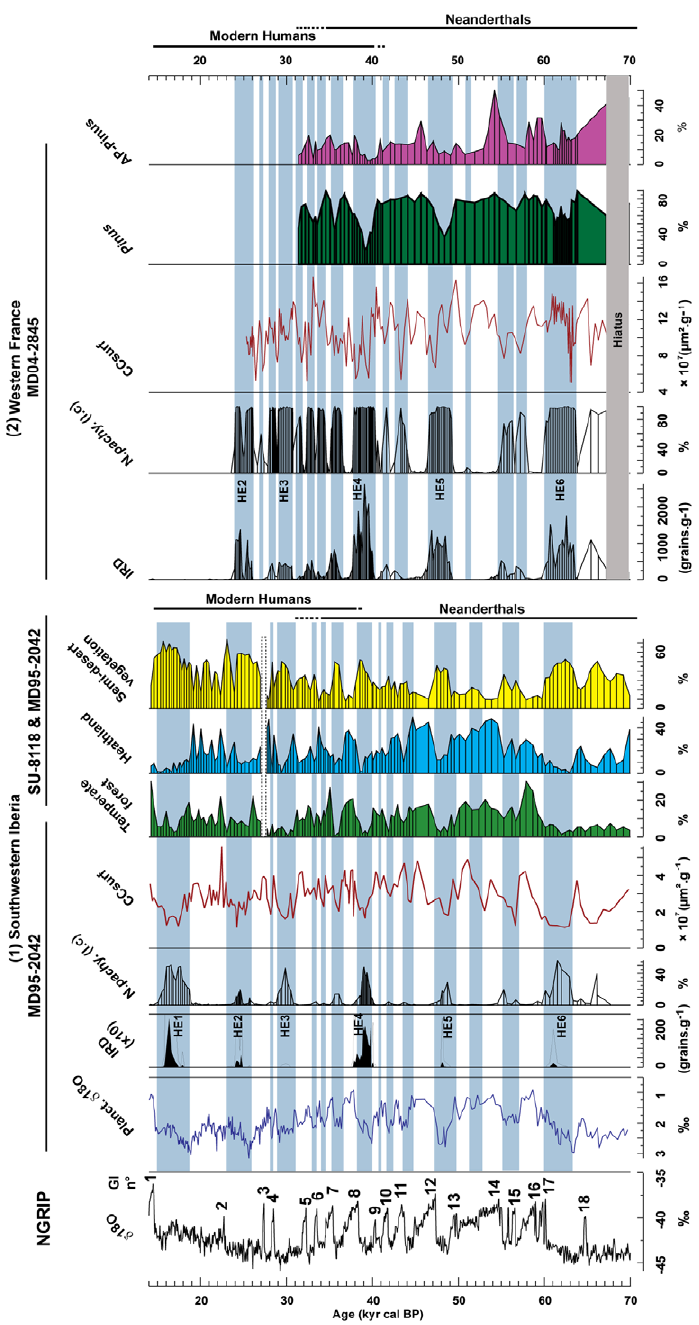
Figure 2. Comparison between concentrations of microcharcoal surface area (CCsurf) and climatic proxies of core MD95-2042 (Southwestern Iberia) (1) and MD04-2845 (Western France) (2). All records are plotted versus age. From left to right: (a) the NorthGRIP oxygen isotopic curve [119]; Southwestern Iberia: (b) the oxygen isotopic curve of the planktonic foraminifera Globigerina bulloides reflecting sea surface temperature and salinity changes [41], (c) the concentration curve of the ice rafted debris (IRD) and (d) the percentage curve of the polar foraminifera Neogloboquadrina pachyderma (s) left coiling[38], (e) the concentrations of microcharcoal surface area (CCsurf), (f) to (h) pollen percentage curve of: temperate forest including Mediterranean plants; Ericaceae (heather); semi-desert vegetation ( Artemisia , Chenopodiaceae, Ephedra). The pollen data for core MD95-2042 are from [43]. The pollen data for the interval 14–25 kyr cal BP are from the twin core SU81-18 [120]. Western France: (a) the concentration curve of IRD, (b) the percentage curve of the polar foraminifera N. pachyderma (s) left coiling, (c) the concentrations of microcharcoal surface area (CCsurf), (d-e) the pollen percentage curve of Pinus and Arboreal Pollen (mainly composed of Picea , Abies , Betula , Cupressaceae, Hippopha¨e, deciduous Quercus , Carpinus and Corylus ; Pinus excluded: Pinus pollen type is overrepresented in marine cores which precludes its inclusion in the calculation of AP percentages [44]. Grey band indicates a sedimentary hiatus in this core. The chronological extent of the Neanderthal and Modern Human populations are reported for the two regions. Blue bands indicate Heinrich Stadials (HSs) and other Greenland Stadials (GSs). HSs are identified on the basis of peaks in ice rafted debris (IRD), high percentages of the polar foraminifera (N. pachyderma (s.) and AMS 14 C ages. GI numbers indicates Greenland Interstadials.